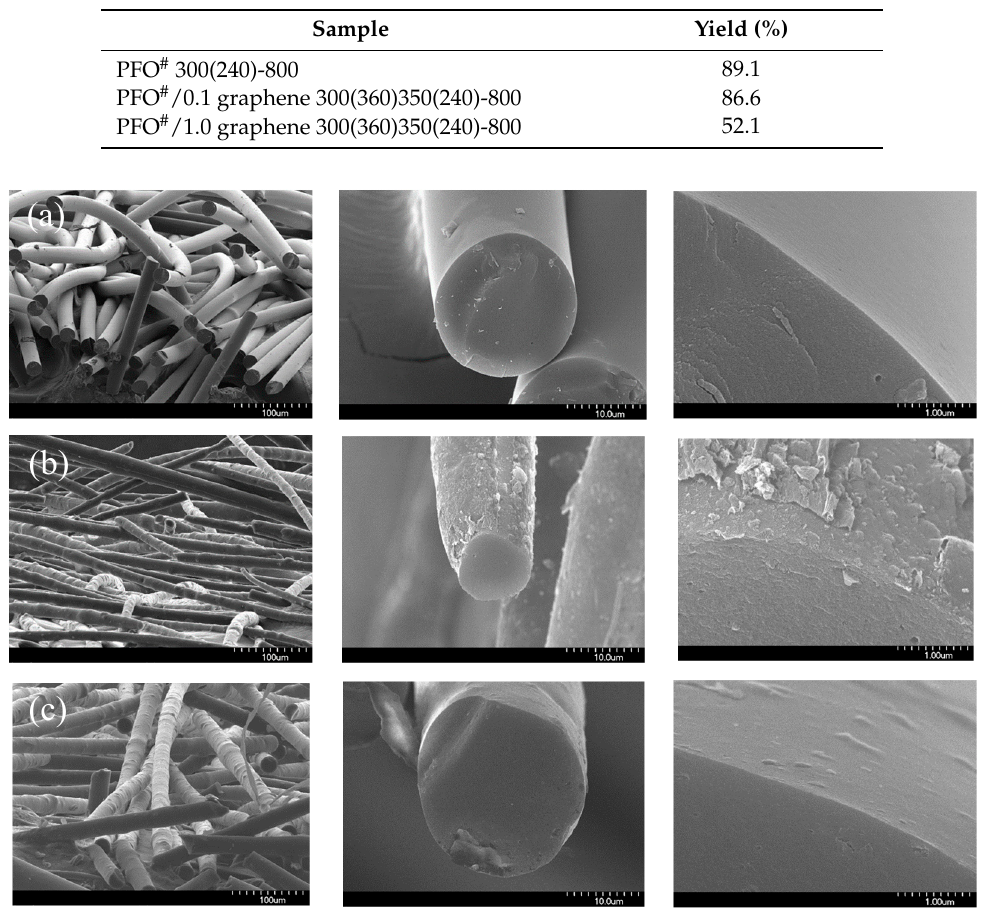
Figure 10. Oxidized PFO # -based carbon fibers; ( a ) PFO # , ( b ) PFO # /0.1 graphene, and ( c ) PFO # /1.0 graphene. Table 6. Yields of Carbon Fibers after Oxidation at 500 °C in Air.